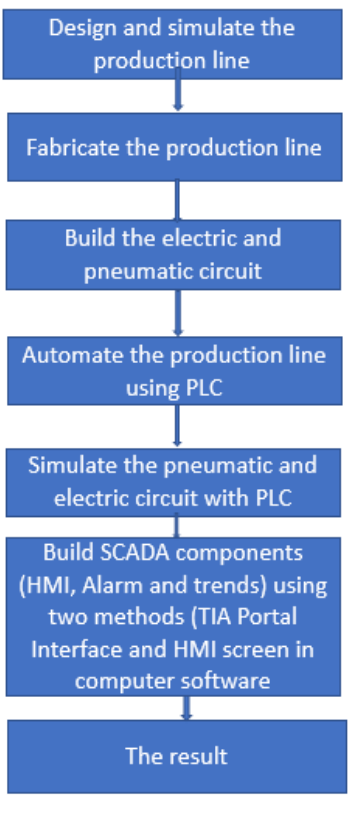
Fig. 3. the methodology .